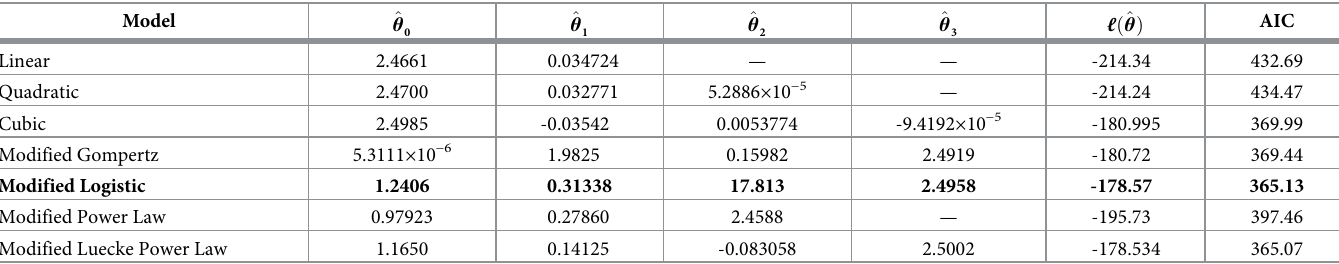
Table 9. Maternal plasma volume models (volume in L vs. fetal mass in kg for power law models, volume in L vs. gestational age in weeks for all other models).